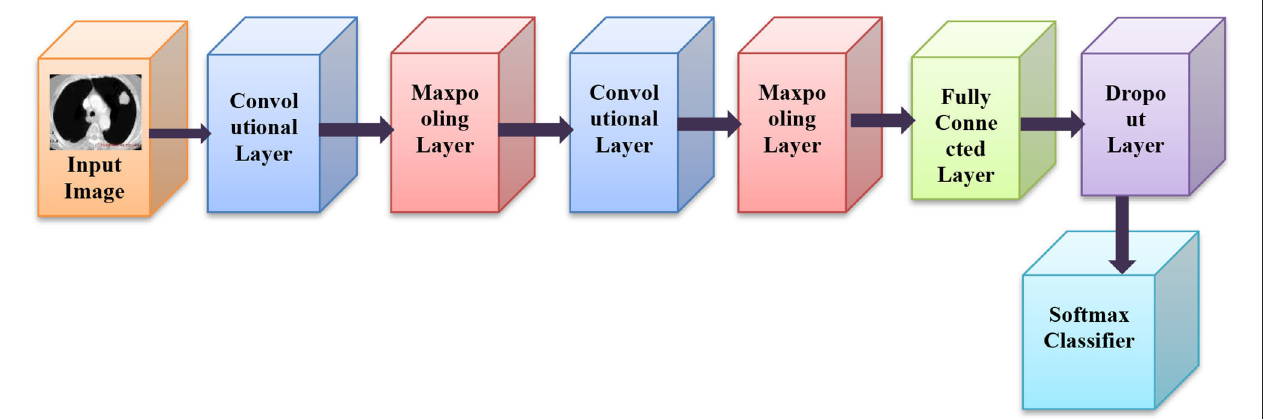
FIGURE 2 | Architecture of CNN.